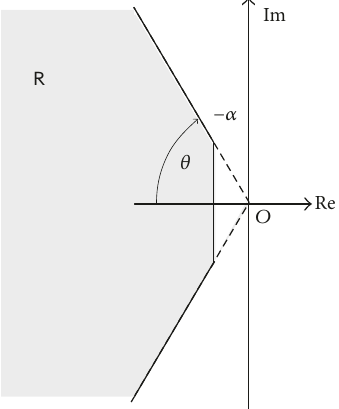
Figure 4: Region R in the complex